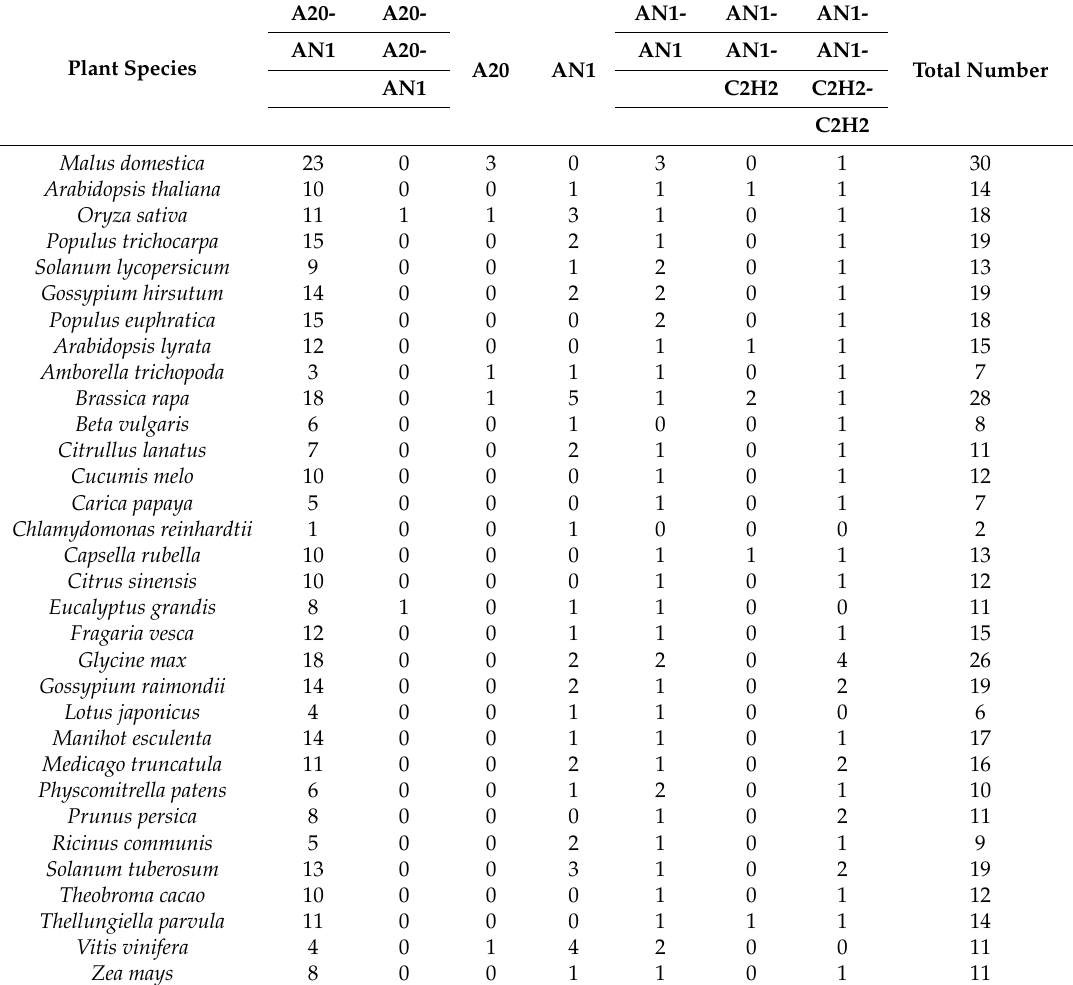
Table 3. Numbers of SAP gene family members in various